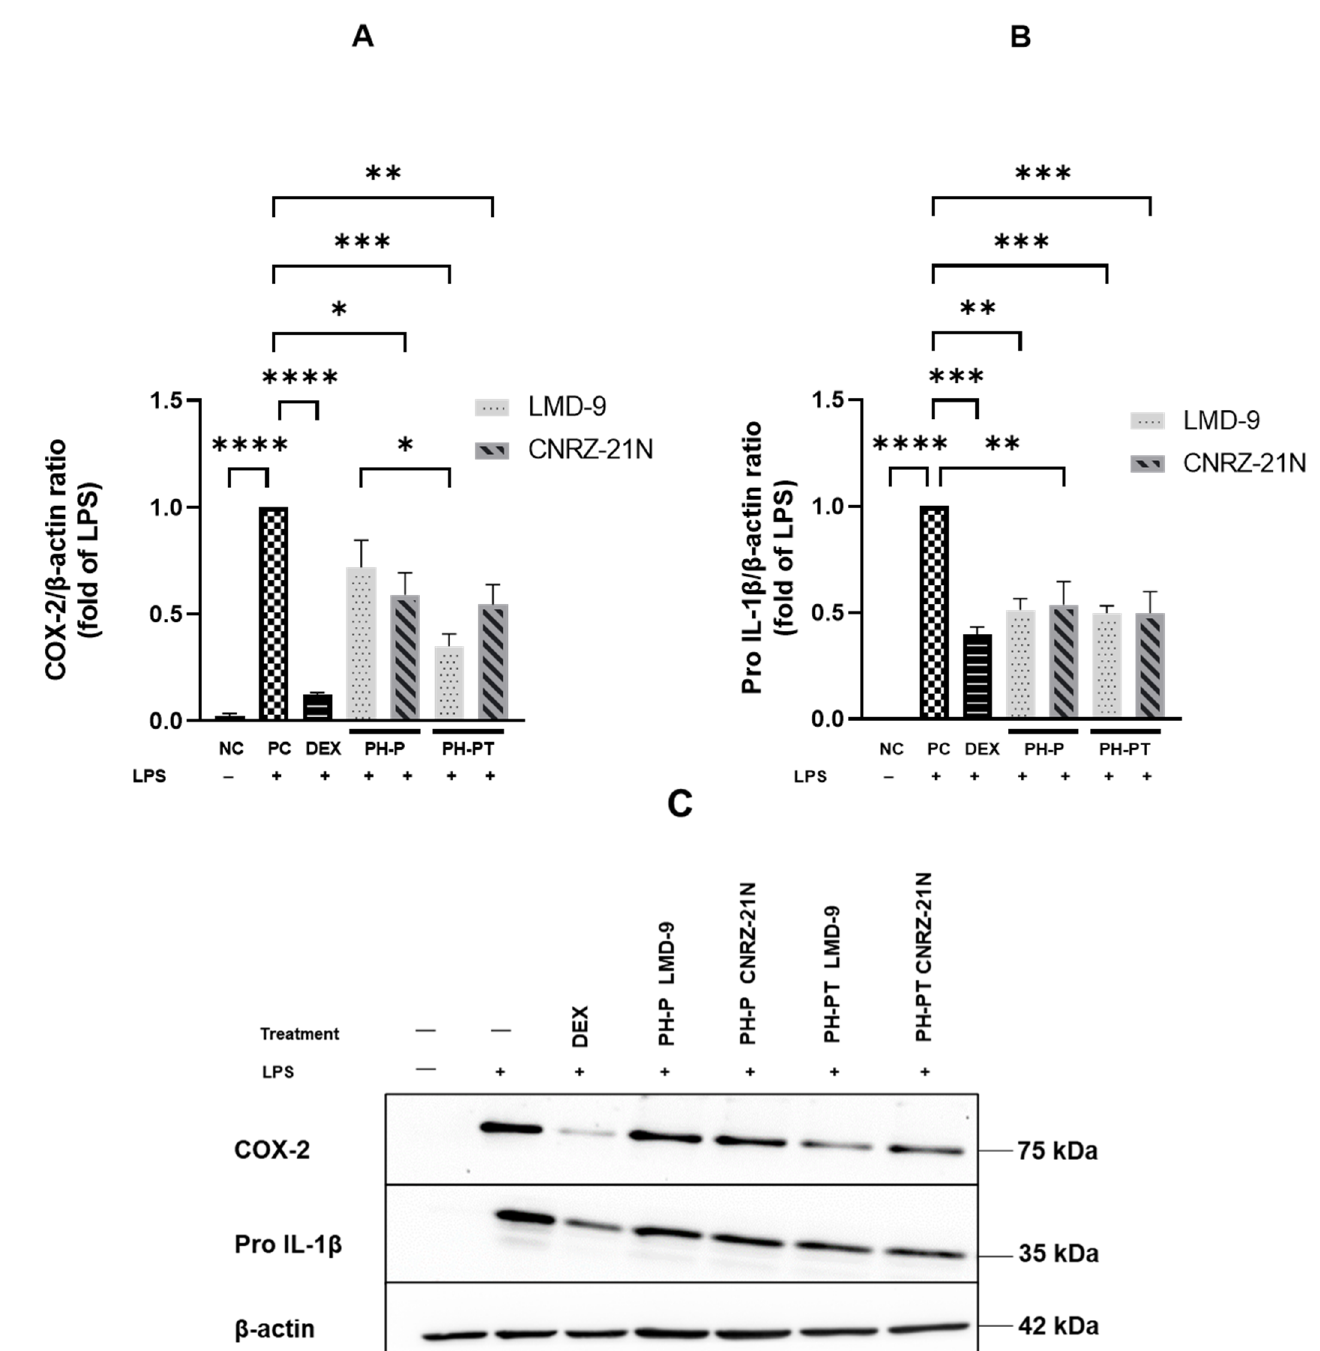
Figure 2. The effects of hydrolysates recovered after peptic shaving (PH-P) or peptic shaving followed by trypsinolysis (PH-PT) of the LMD-9 and CNRZ-21N strains on the protein expression of COX-2 ( A , C ) and Pro-IL-1 β ( B , C ) in the LPS-stimulated THP-1 macrophages. Three hour co-incubation of the THP-1 macrophages was performed either with LPS (50 ng/mL) alone, or with LPS and PH-P (3 mg/mL) or LPS and PH-PT (3 mg/mL) or LPS and dexamethasone (DEX, 25 µM). Protein content (15 µg) of each sample was loaded on 10% SDS-PAGE. The band intensities were determined by image Lab software and the results were calculated as a relative intensity to the β -actin. All data are expressed as the means ± SEM of three experiments performed independently (N = 3). * p < 0.05, ** p < 0.01, *** p < 0.001, **** p < 0.0001.